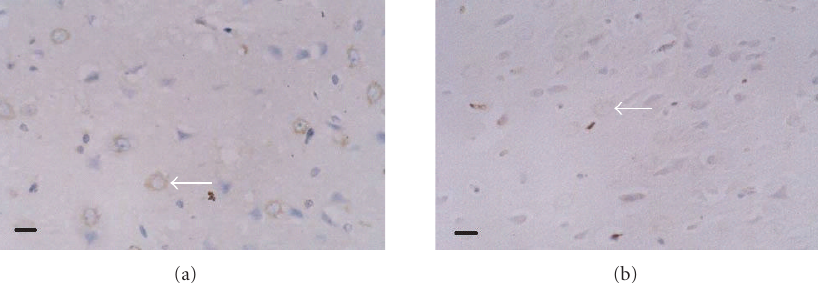
Figure 3: Immunohistochemical staining for iNOS protein expression in (a) vehicle-treated rats and (b) theaflavin-treated rats (20mg/kg), SP × 400. The number of iNOS immunoreactive positive cells in theaflavin-treated groups is significantly less than that of vehicle-treated group. Scale bar = 10 μ m.